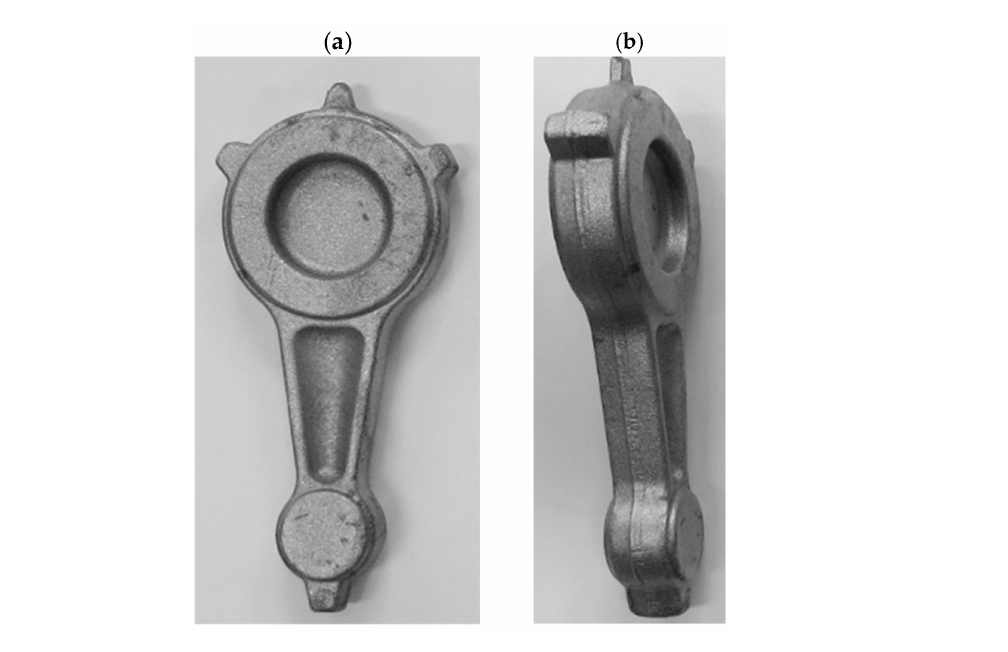
Figure 30. Forgings of connecting rods made of AB-71100 aluminum alloy after the process of trimming the flash and etching obtained from cast preforms in accordance with variant 2: ( a ) top view; ( b ) side view.